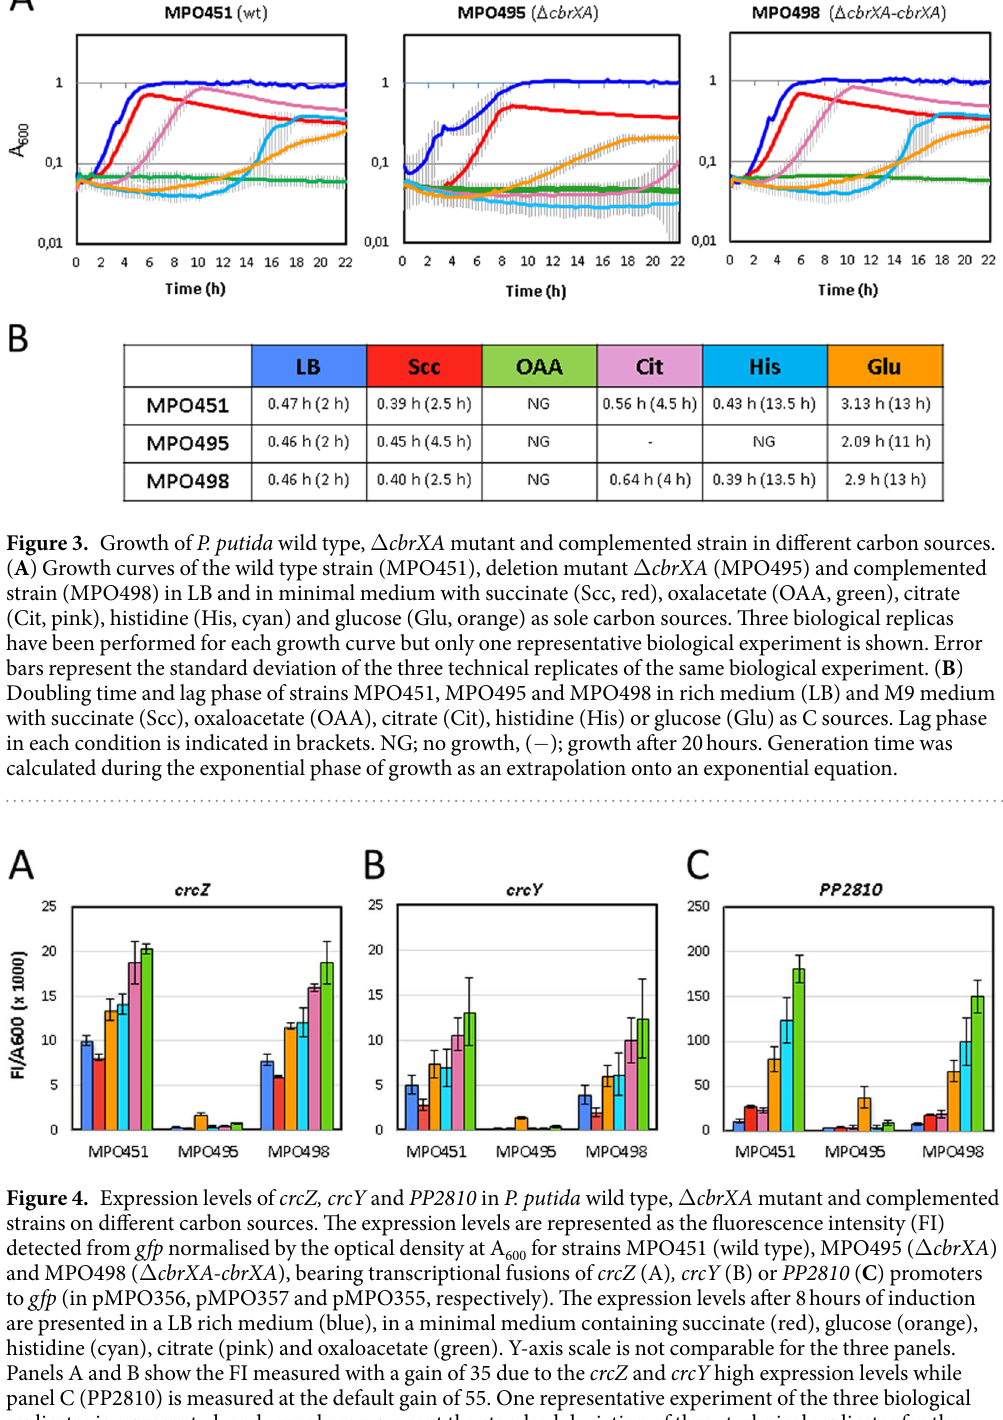
wild type. The expression pattern was also conserved in a Δ cbrB background (MPO401), thus showing these